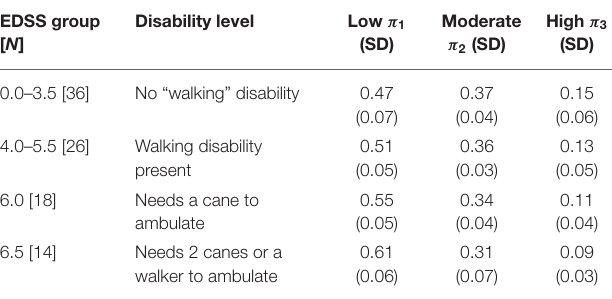
TABLE 3C | Proportion of physical activity level distribution per disability (EDSS) group (distribution of π